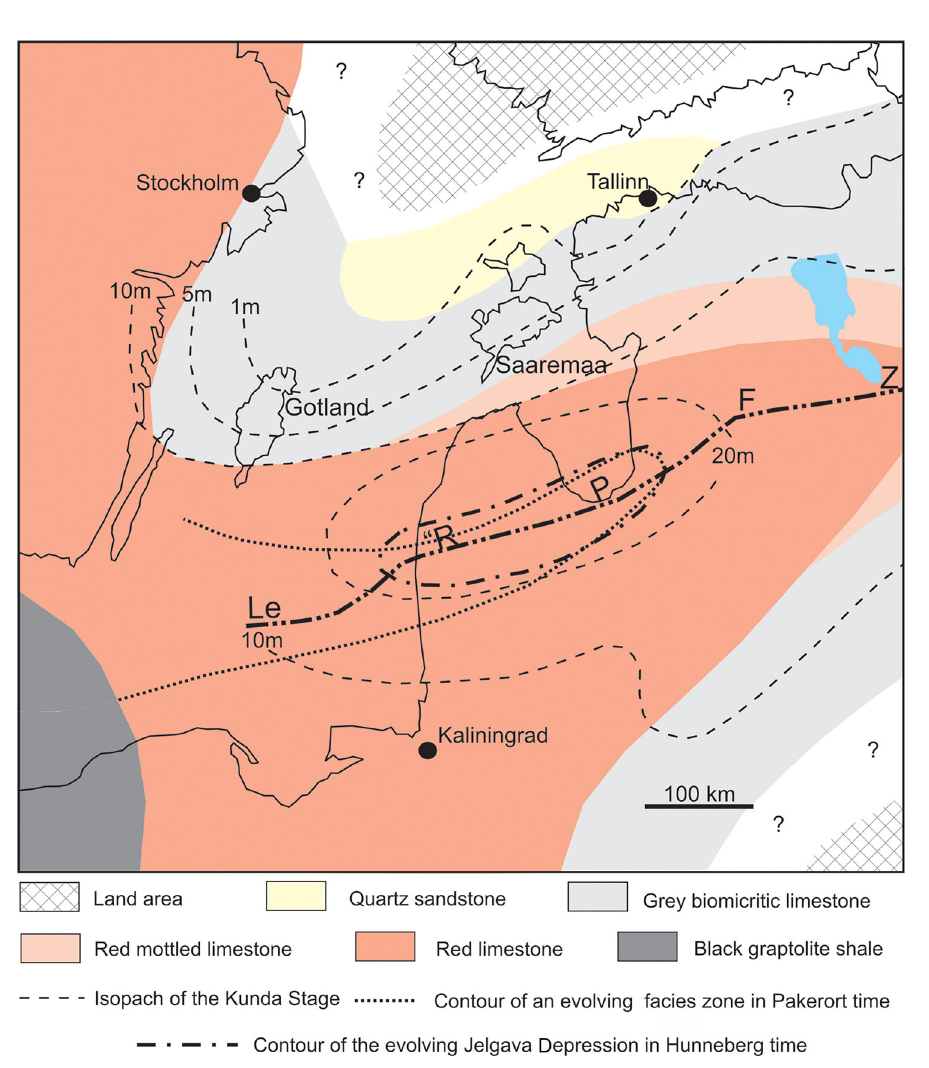
Fig. 11. Sketch of the Baltic Basin facies/thickness distribution with the Livonian Tongue in early Darriwilian (Kunda) time (modified after Männil